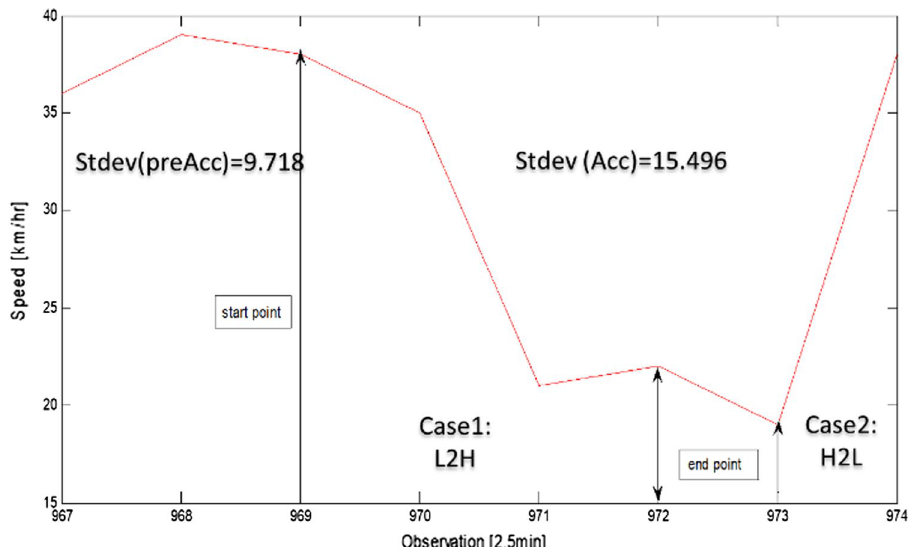
Fig. 4 Calculated standard